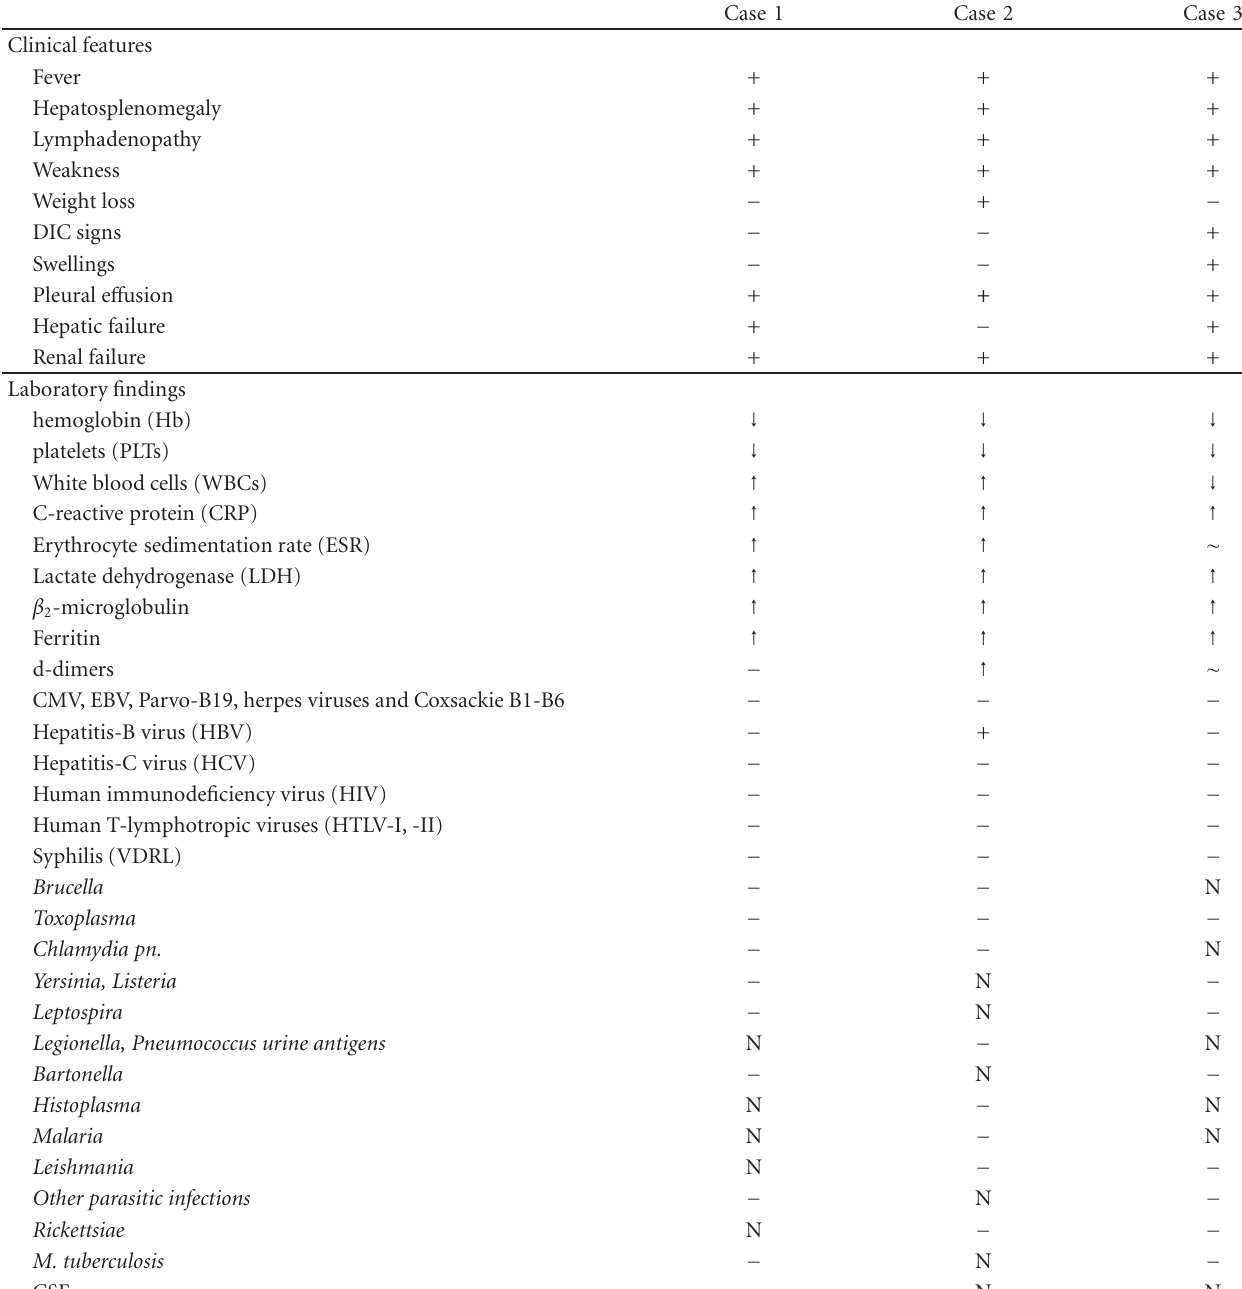
Table 1: The main clinical features and laboratory